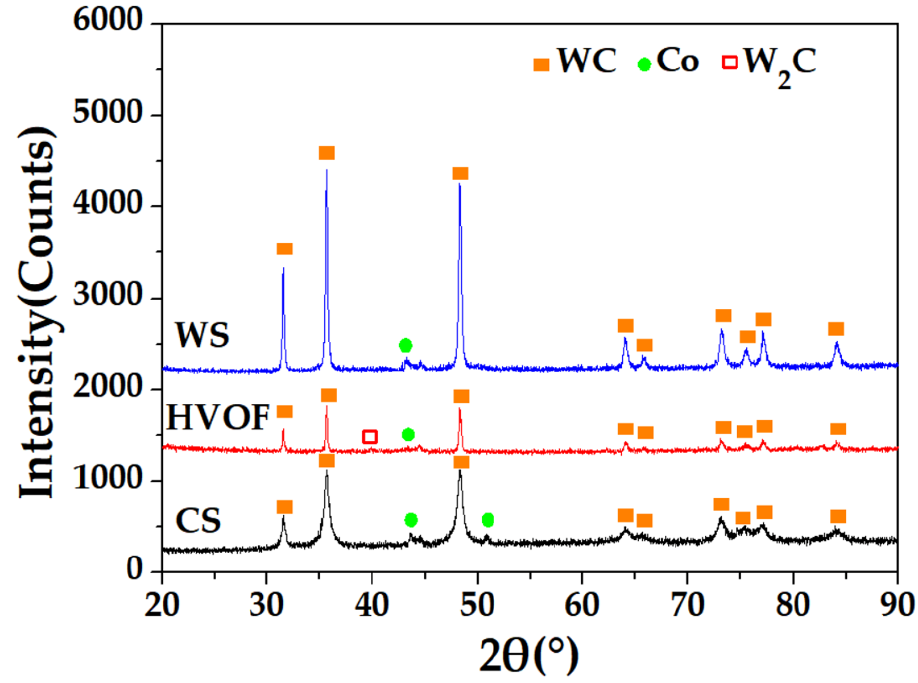
Figure 9. XRD patterns of WC-17Co coatings formed in various spraying ways.